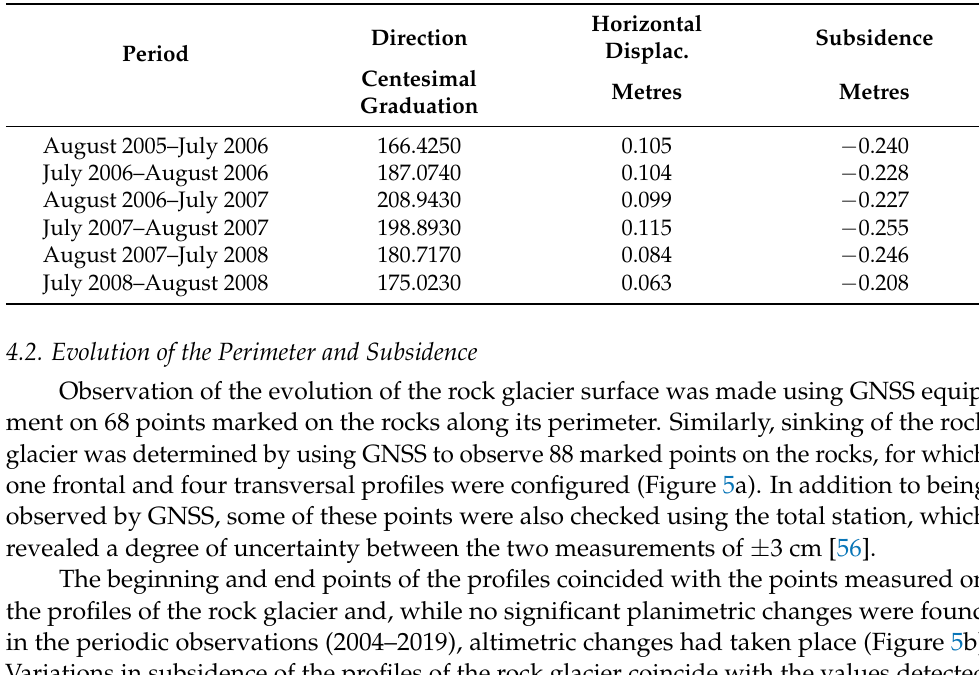
Horizontal Displac.